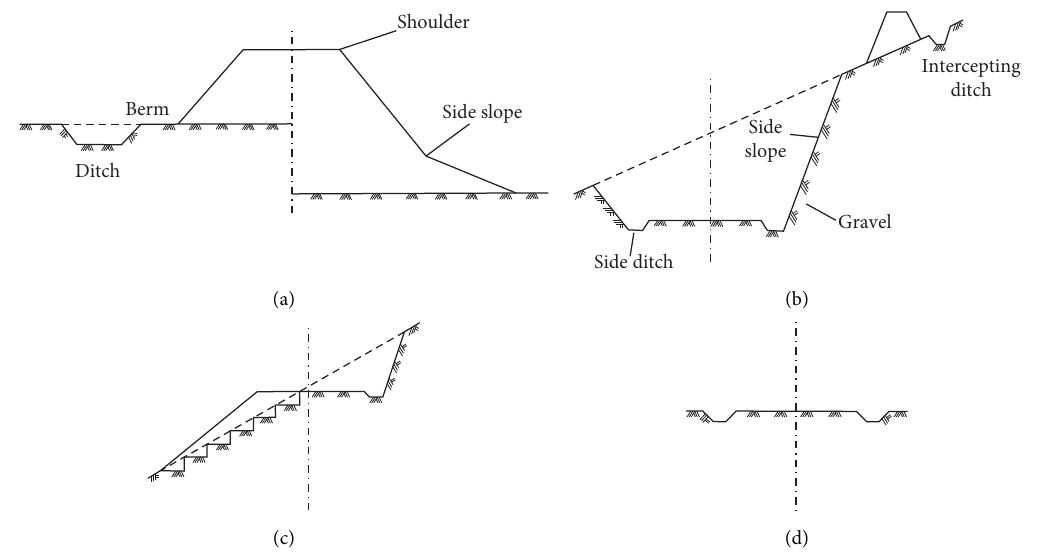
Figure 2: Diagrammatic drawing of the subgrade type. (a) Embankment. (b) Cutting. (c) Half-filled and half-dug. (d) No digging and no